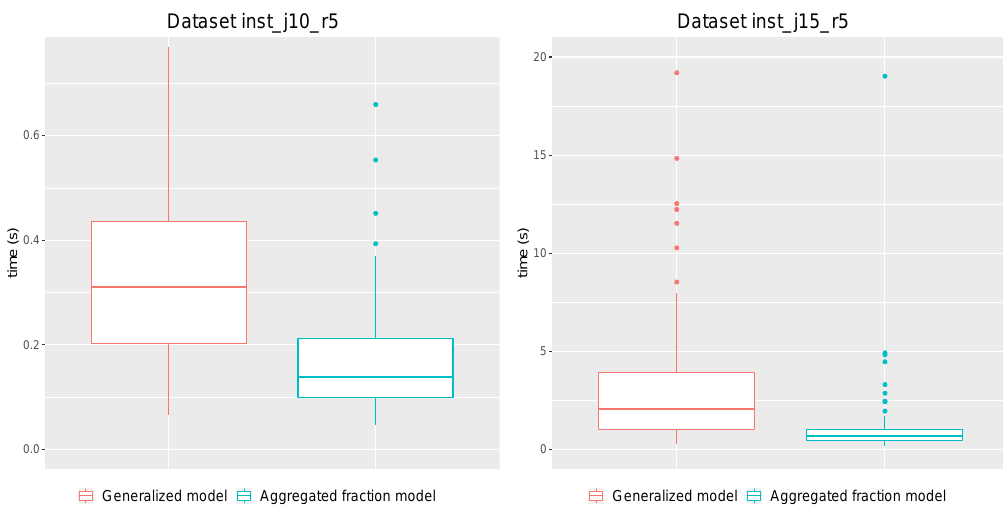
Figure 3. Time boxplots for datasets inst _ j 10_ r 5 and inst _ j 15_ r 5.